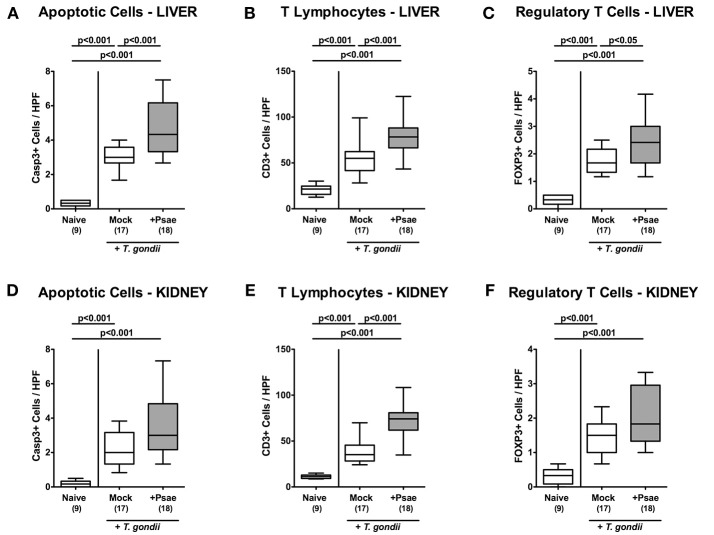
Apoptotic epithelial cell as well as immune cell responses in the liver and kidney following peroral MDR P. aeruginosa challenge of mice with a human gut microbiota suffering from subacute ileitis. At day 5 following subacute ileitis induction, mice with a human gut microbiota were either perorally challenged with MDR P. aeruginosa (+Psae, dissolved in PBS) or with PBS alone (Mock). Uninfected mice with a human gut microbiota but without ileitis served as control animals (Naive). 96 h following Psae challenge, the average numbers of apoptotic (Casp3+; A,D) epithelial cells as well as of T lymphocytes (CD3+; B,E) and regulatory T cells (FOXP3+; C,F) in at least six high power fields (HPF) were quantitatively assessed in hepatic (A–C) and renal (D–F) paraffin sections applying in situ immunhistochemistry. Box plots represent the 75th and 25th percentiles of the median (black bar inside the boxes). The total range and significance levels determined by one-way ANOVA test followed by Tukey post-correction test for multiple comparisons are shown. The total numbers of analyzed animals are given in parentheses. Data were pooled from four independent experiments.